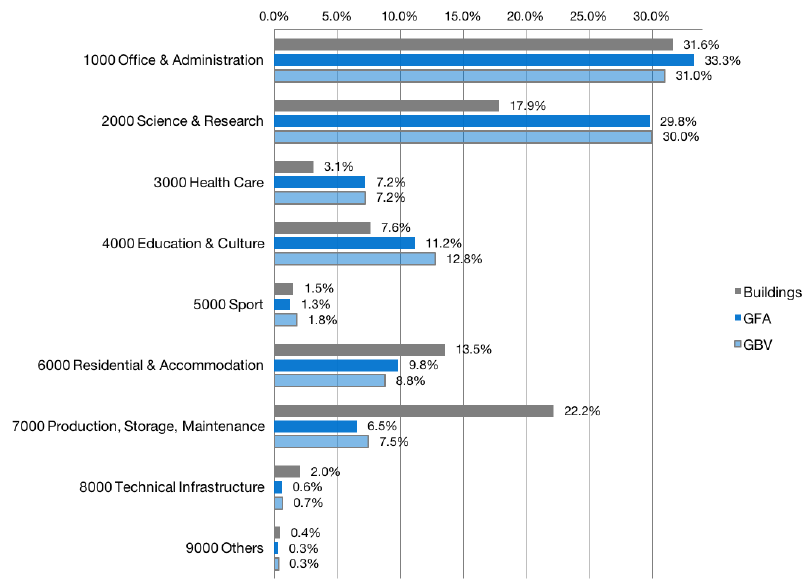
Figure 2. Percentage of building types among the building properties of the Free State of Bavaria, according to the first digit of their type in the Bauwerkzuordnungskatalog (BZK) (own representation according to [10]).